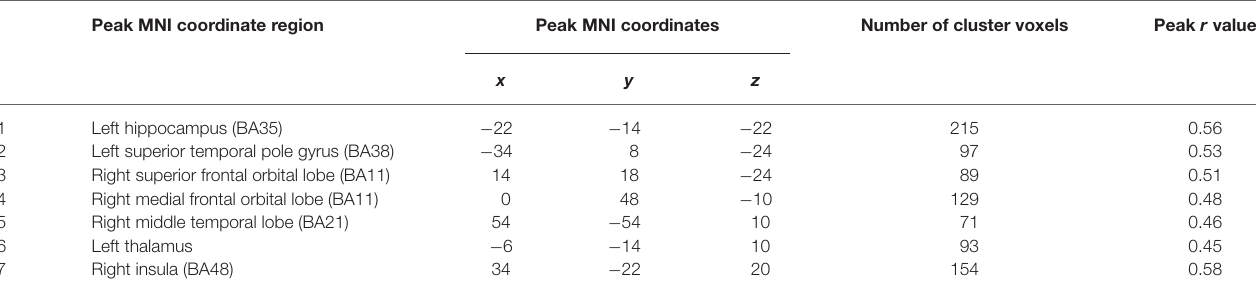
TABLE 2 | Regions showing significant correlation with z -scores and regional CBF in SVCI group. Peak MNI coordinate region Peak MNI